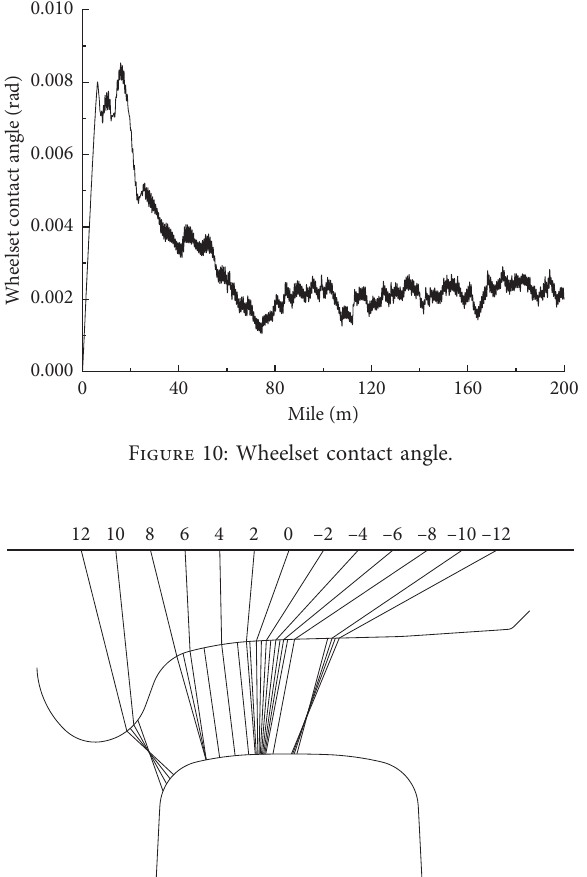
Figure 11: Schematic diagram of wheel-rail contact point